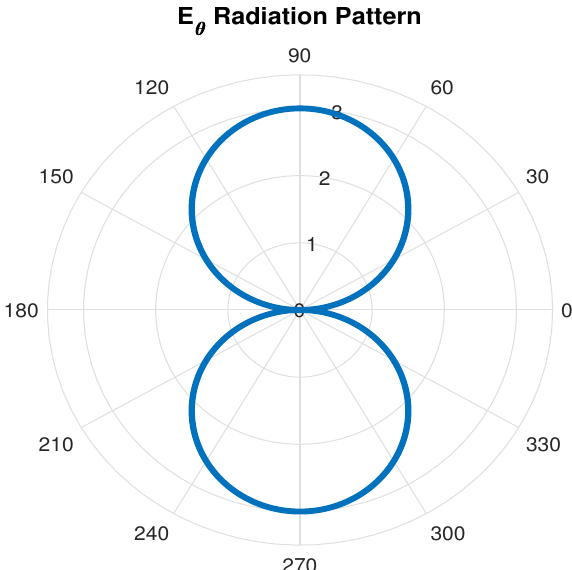
Figure 13. Far-field electric field